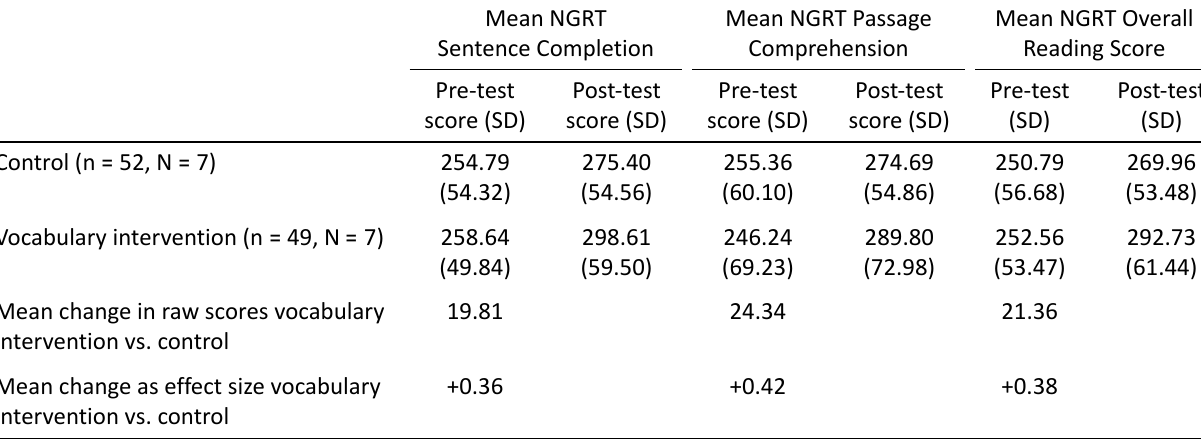
Table 3. Pre‐ and post‐test results in NGRT reading